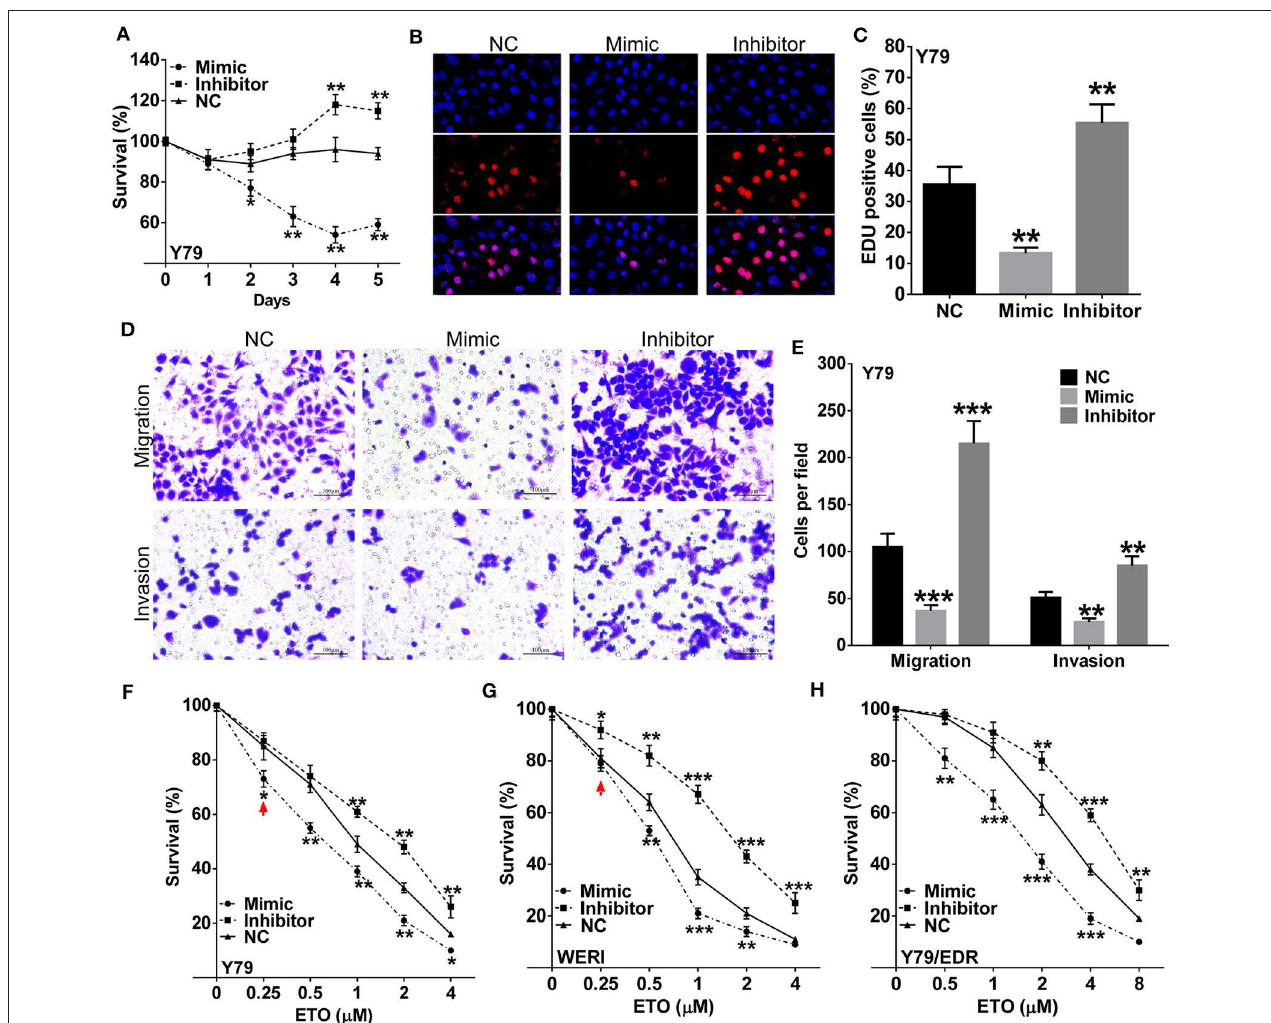
FIGURE 2 | miR-184 is a tumor-suppressive miRNA and enhances chemosensitivity in retinoblastoma (RB) cells. (A) Y79 cells were transfected with miR-184 mimic, inhibitor, or negative control (NC). Cell viability was detected by methyl thiazolyl tetrazolium (MTT) assay. (B) Y79 cells were transfected with miR-184 mimic, inhibitor, or negative control (NC). Cell viability was detected by 5-Ethynyl-’-deoxyuridine (EdU) assay after 48h. (C) Statistical analysis of the EdU-positive cell ratio in Y79 cells with different transfection. (D) Transwell assay of the migration and invasion ability inY79 cells with different transfection. Scale bar: 100 µ m. (E) Statistical analysis of the cell numbers through the chamber in Y79 cells with different transfection. Y79 cells (F) , WERI cells (G) , and Y79/EDR cells with different transfection were treated with different concentrations of ETO for 48h. (H) Cell viability was detected by MTT assay. Data were presented as mean ± SD of three independent experiments. * P < 0.05, ** P < 0.01, *** P < 0.0001 vs. negative control